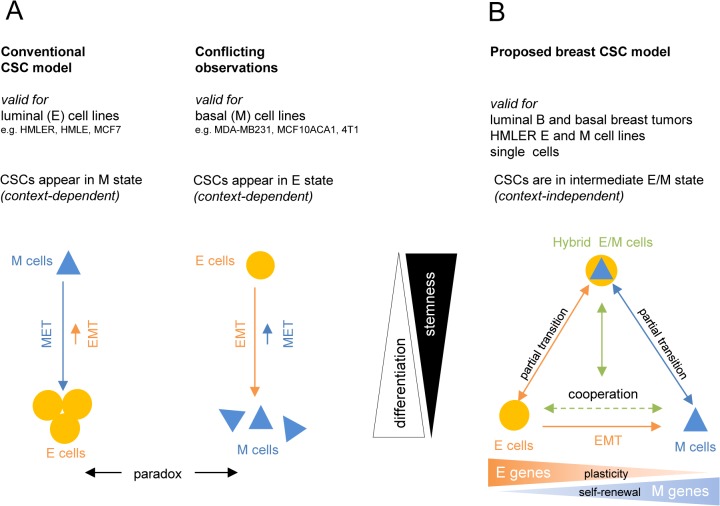
The conventional versus a new integrative CSC model for breast cancer.(A) In luminal epithelial cell-lines (e.g. in HMLE, HMLER, MCF7) the conventional model describes breast CSCs as M cells and ‘non cancer stem cells’ as E cells. Paradoxically, in more basal mesenchymal cancer cell-lines (MDA-MB231 cells, MCF10ACA1, 4T1) the more E gene-expressing cells are associated with CSC-properties. Thus, the identity of CSCs appears to be context-dependent. (B) Our model for CSCs integrates and explains these paradoxes by the existence of stem-like intermediate hybrid E/M cells independent of the tumor cell line. We propose that compared to more ‘polarized’ differentiated E (capable of plasticity) and M cell-types (capable of self-renewal), undifferentiated hybrid E/M cells can generate more mammospheres and heterogeneous progeny due to their capacity of both, self-renewal and plasticity. Arrows indicate possible state transitions (incomplete EMT and MET) between the instable hybrid E/M state and the extreme stable E and M states. Stemness of the intermediate E/M state is reflected both by presence of stem-like hybrid E/M cells and by co-presence of E and M cell-types due to cooperation. Context-independency of the stemness of the intermediate E/M state explains the paradoxical context-dependent meaning of E genes in basal tumors and M cell lines and stemness of M genes in luminal B tumors and E cell-lines (A).